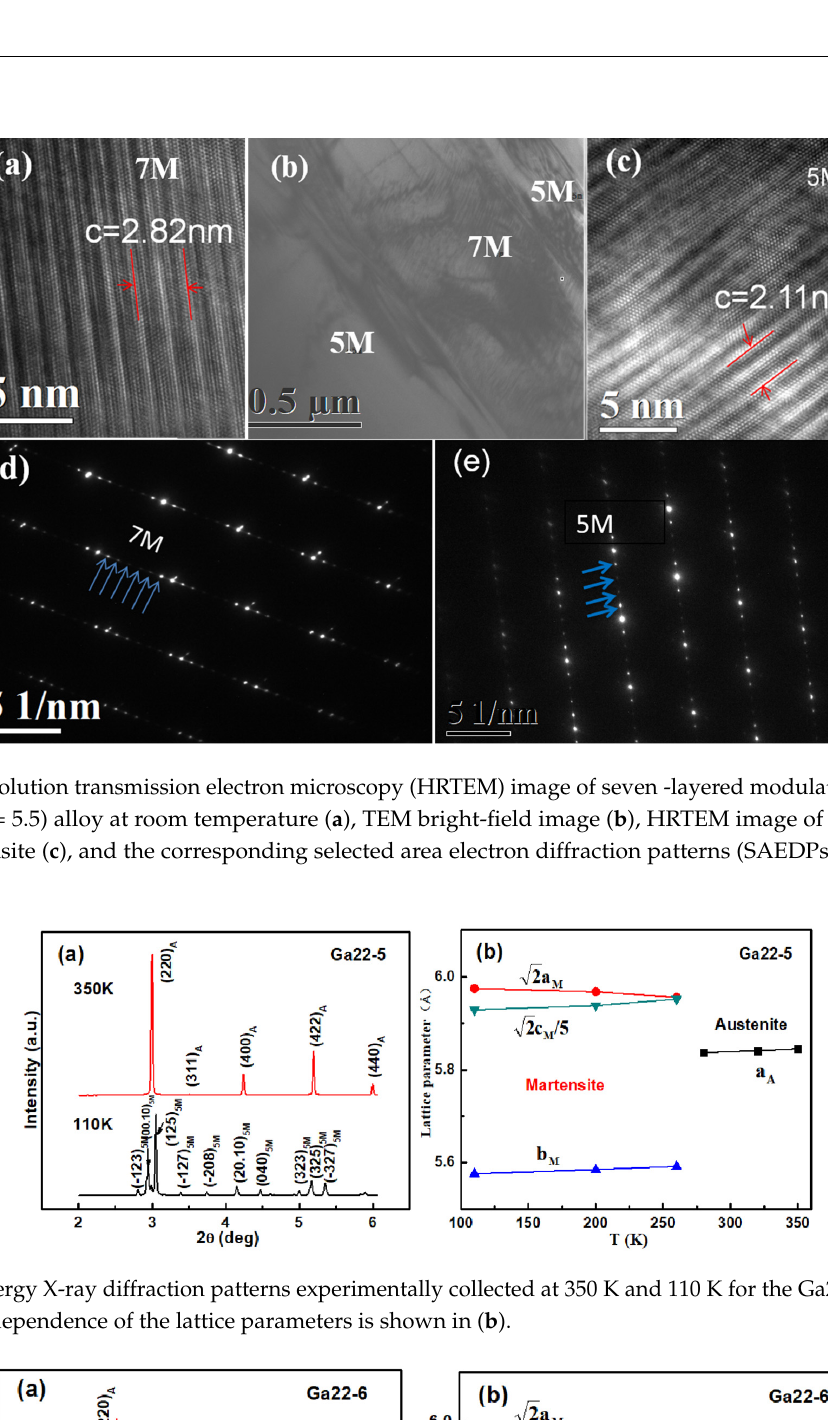
Figure 8. High-energy X-ray diffraction patterns experimentally collected at 350 K and 110 K for the Ga22-5 ( x = 7) alloy ( a ). The temperature dependence of the lattice parameters is shown in ( b ).